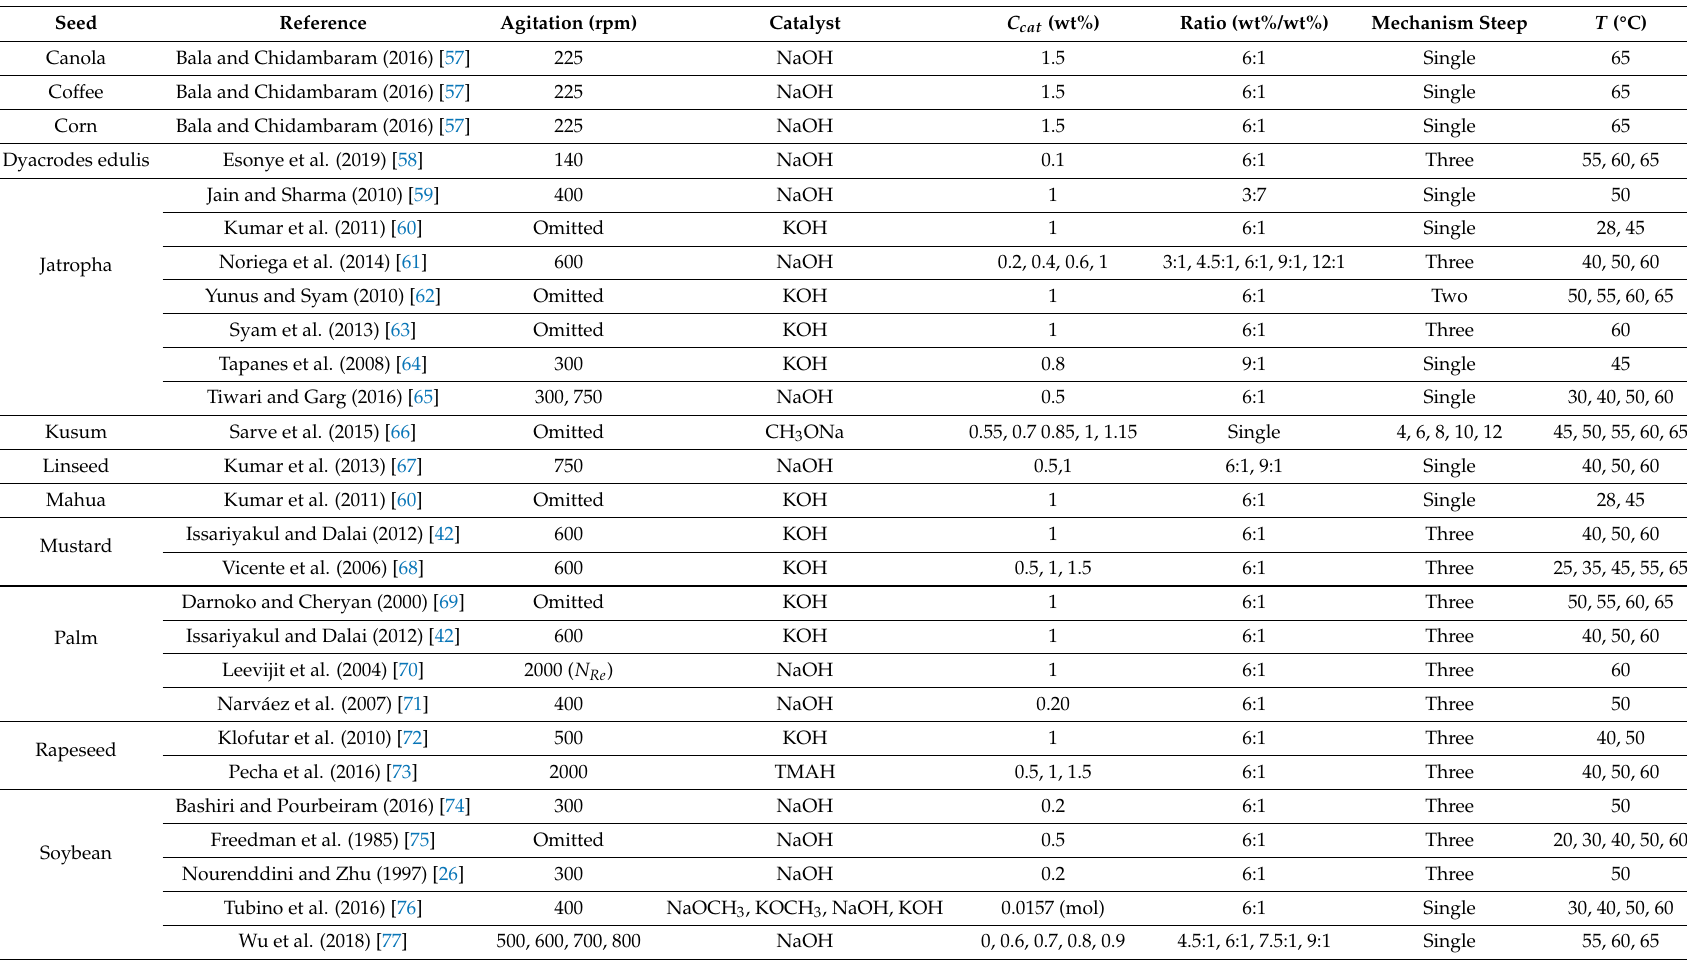
Table 2. Kinetic studies for transesterification of different unused oils with methanol (at atmospheric pressure, with homogeneous alkali-base catalyst, and mechanical